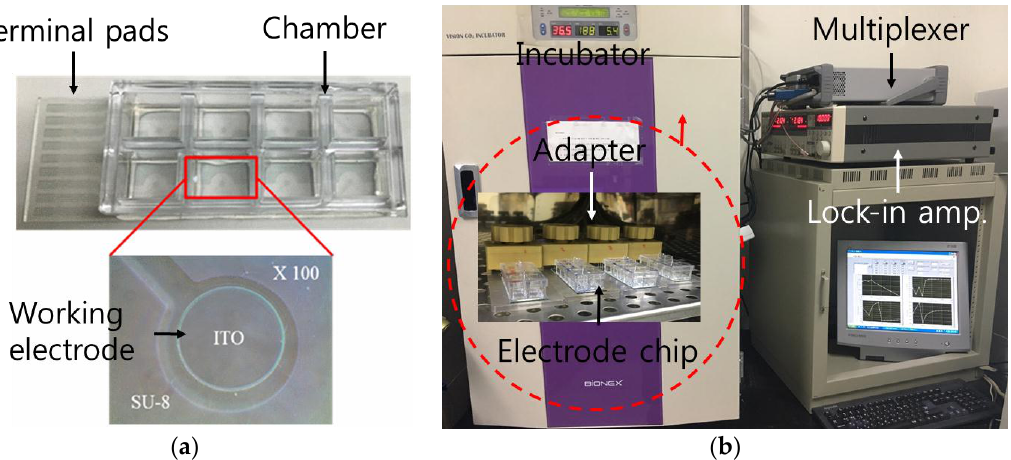
Figure 1. ( a ) Fabricated indium tin oxide (ITO) electrode chip consisting of chamber and terminal pads; ( b ) experimental setup for the impedance measurement of cells.